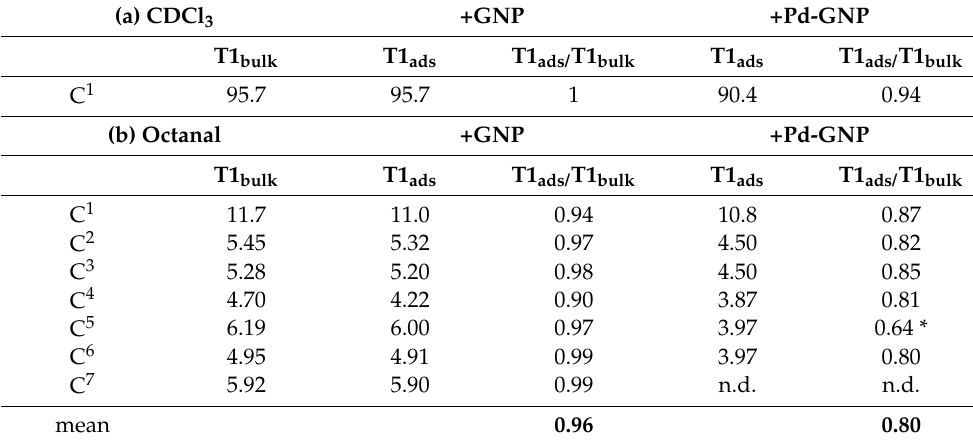
Table 8. Octanal in CDCl